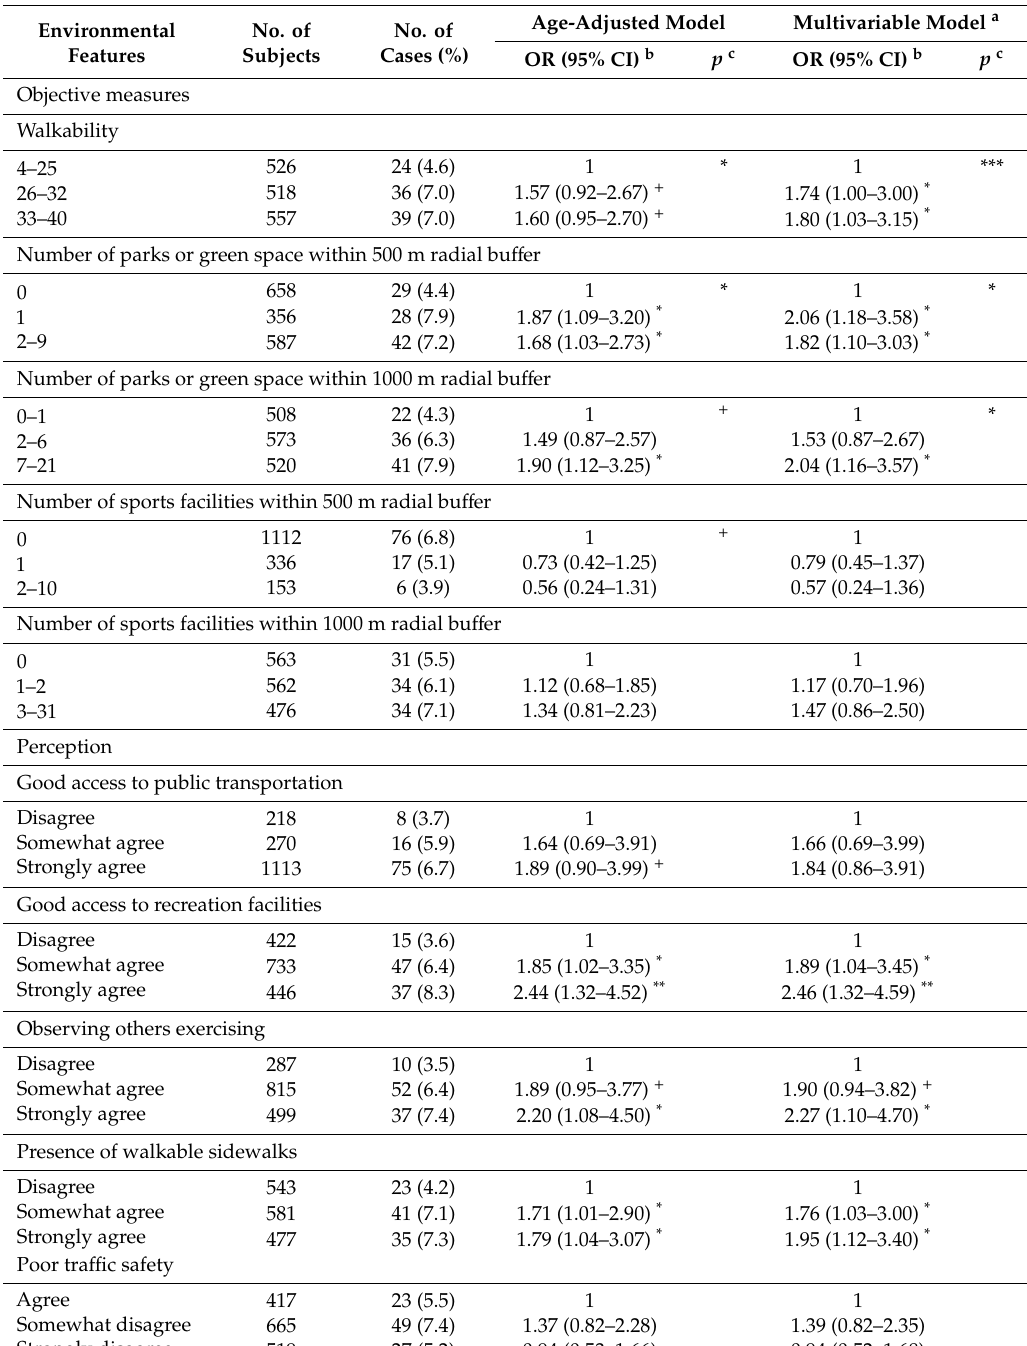
Table 4. Odds ratios for sports habits according to built neighborhood environmental features among retired civil servants, Aichi Worker’s Cohort,